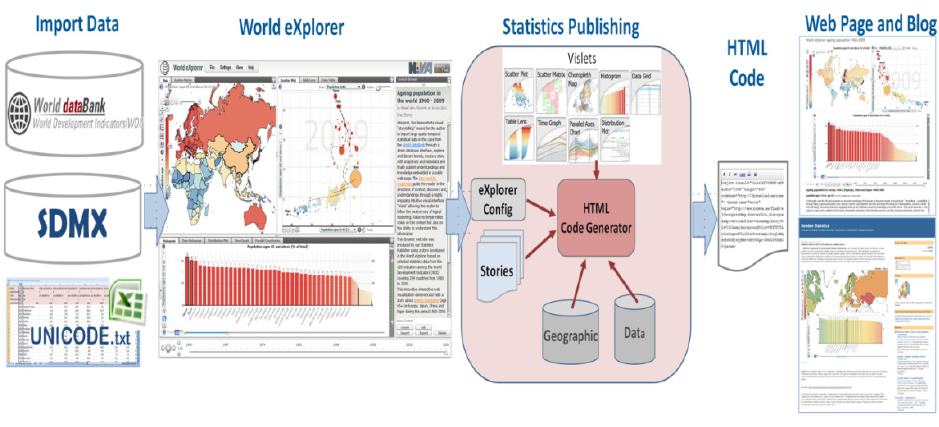
Figure 4. The seamless integration of a teacher authoring tool: importing data, storytelling and publishing interactive education documents for official